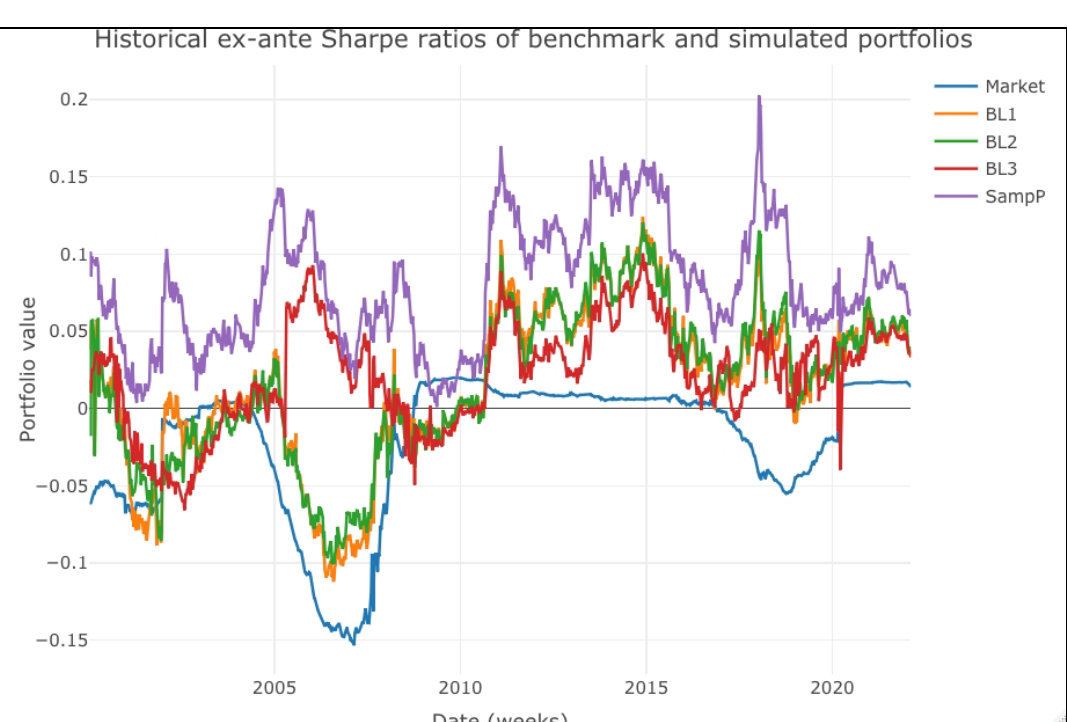
Figure 4. Simulated portfolios’ historical ex-ante Sharpe ratios.